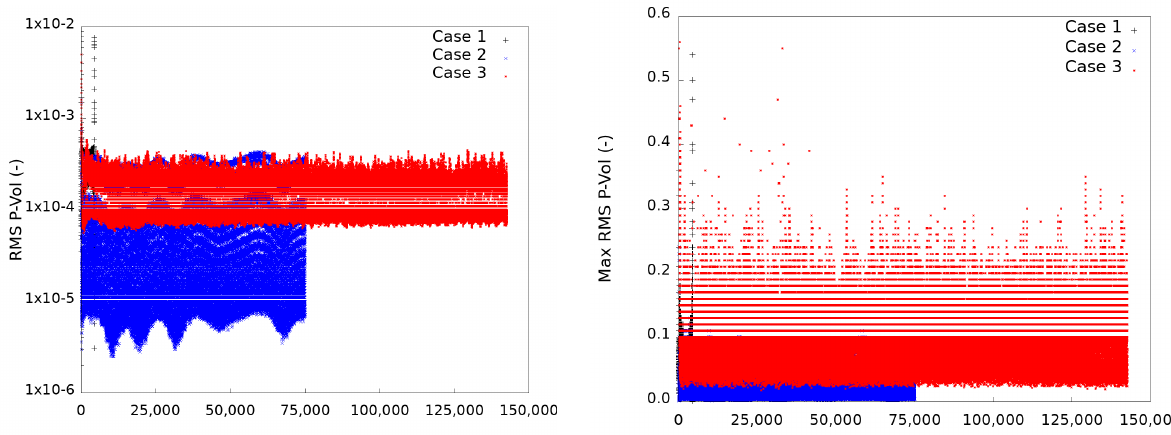
Figure 10. RMS (left) and maximum RMS (right) of the pressure equation.